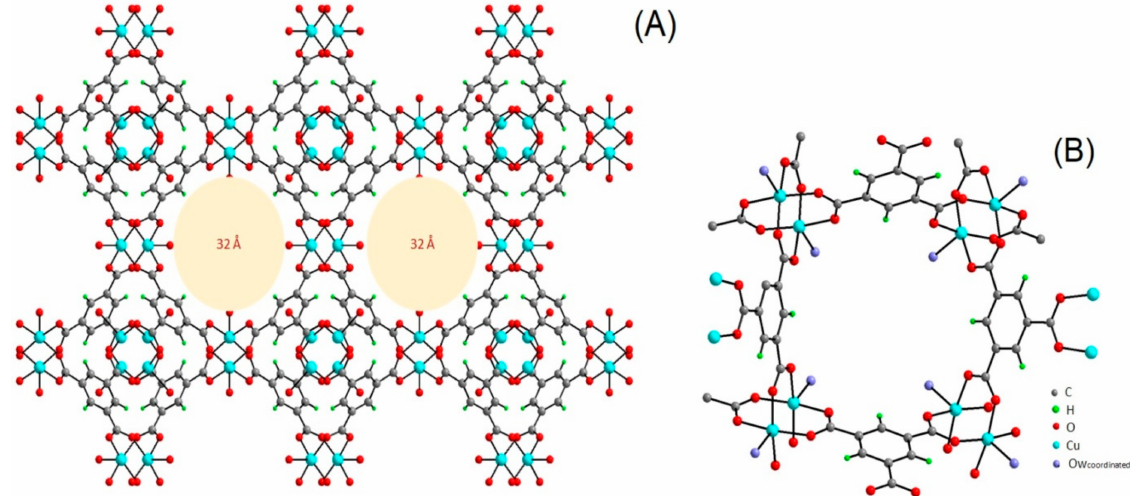
Figure 23. ( A ) Structure of HKUST-1. ( B ) Paddle-wheel secondary building unit (SBU). Reprinted with permission from Ref. [58]. Copyright 2019